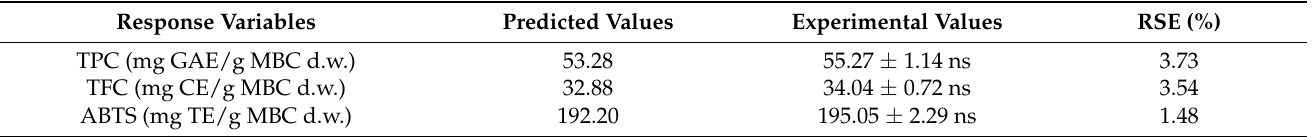
Table 4. Predicted and experimental response values at the optimum extraction conditions. Response Variables Predicted